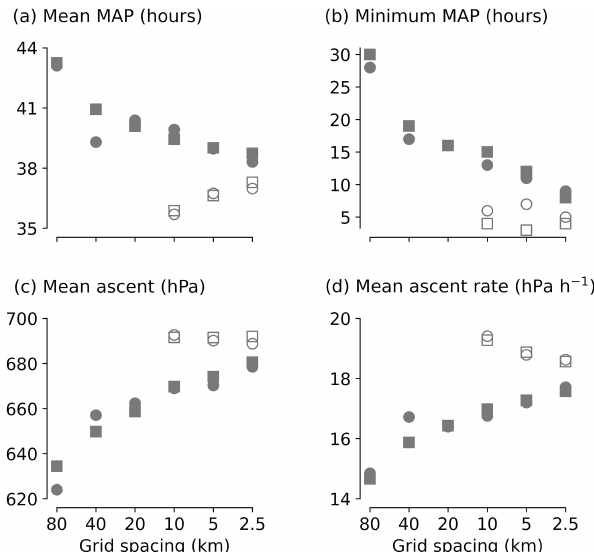
Figure 6. Statistics of the main ascent period (MAP) as a func- tion of horizontal grid spacing. The filled and empty markers repre- sent parameterized and explicit convection, respectively, while cir- cle and square markers represent one- and two-moment cloud mi-